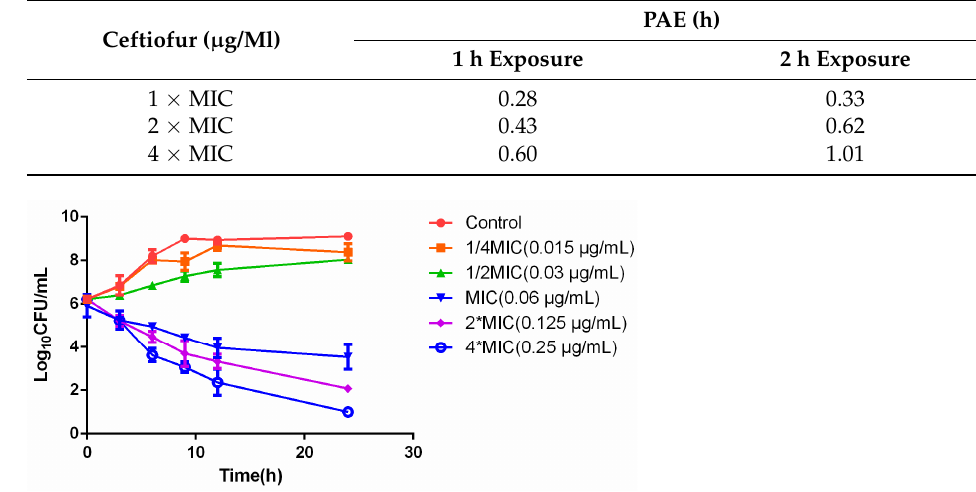
Figure 1. The in vitro time ‐ killing curve of CEF against HB13 in MHB.